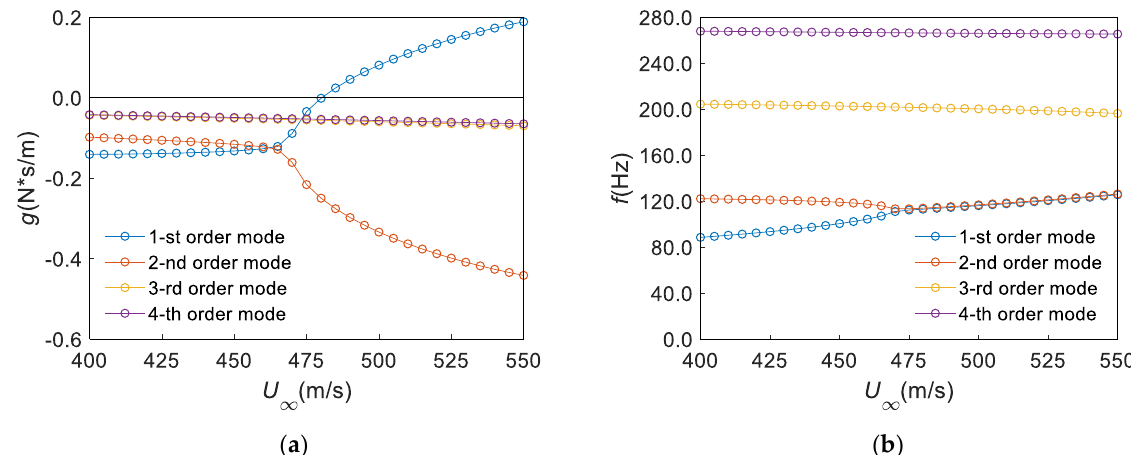
Figure 24. Results of flutter calculation for the panel with no mass attachment (NP) ( Ma ∞ = 2.0): (AR2).